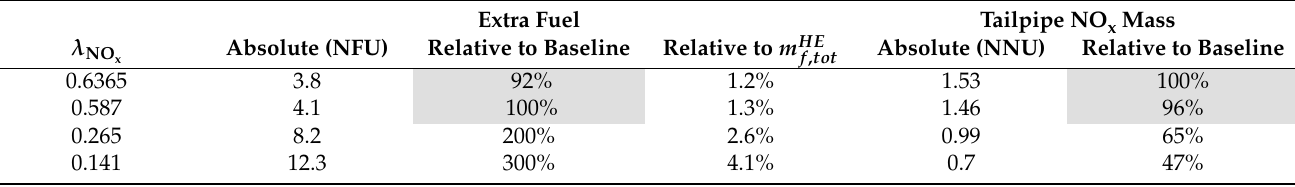
Figure 13. Results from simulations where the strategy is applied on the drayage cycle. The pollution phases are marked with red. Table 1. Summary of the results in Figure 14. m HE corresponds to the total fuel mass when the f , tot high-efficiency mode is used the whole cycle, i.e., the minimum amount of total fuel. The intersections with the baseline strategy are marked